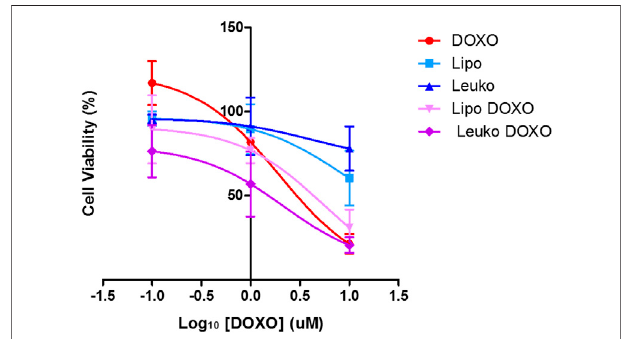
FIGURE10| Cytotoxicity effect ofDOXO,Lipo, Leuko, Lipo-DOXO, and Leuko-DOXO on PDSs. ( n =